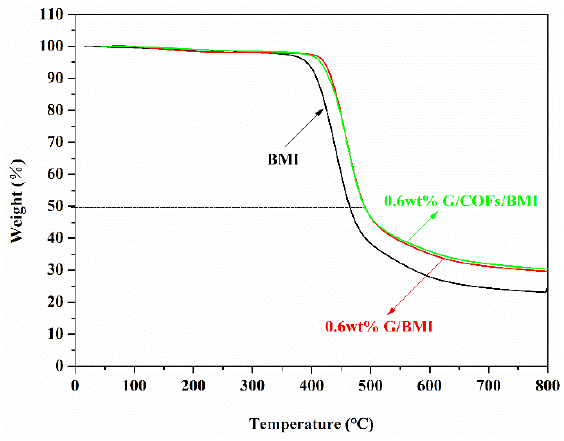
Figure 7. TGA analysis curves of G/COFs/BMI, COFs/BMI, and G/BMI.